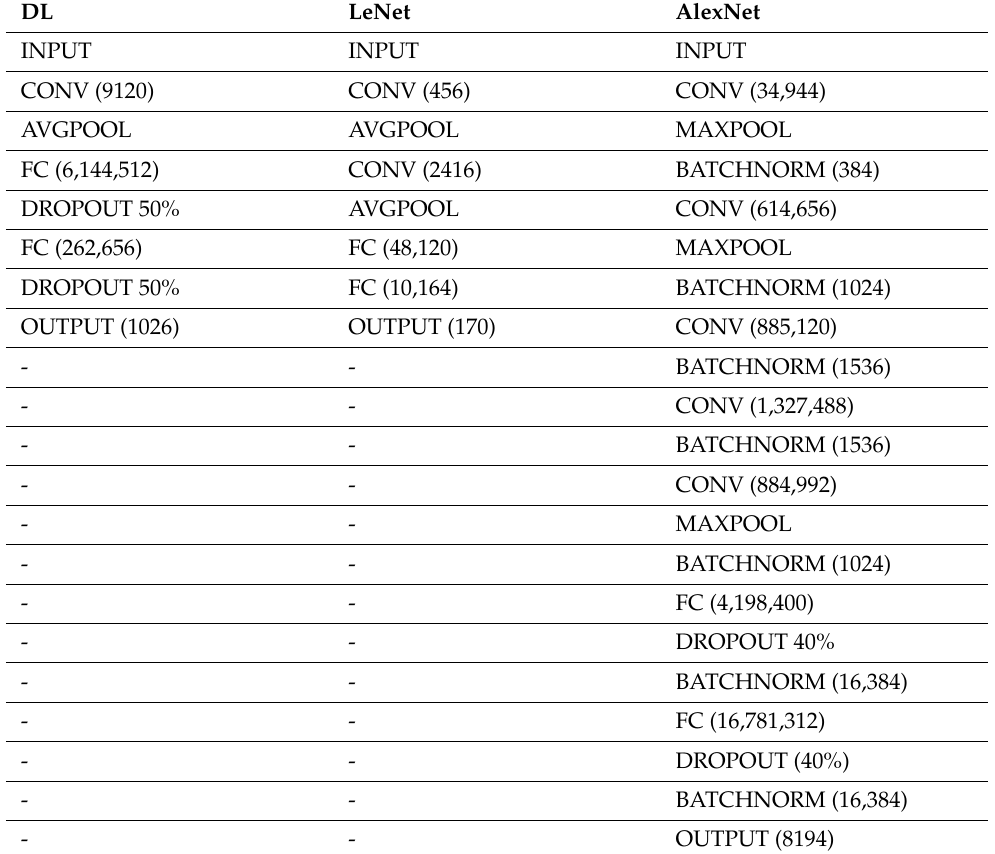
Table 3. Detailed overview of Layer Type (and no. of parameters) for all models. DL is the proposed model. LeNet and AlexNet are the compared models. No. of parameters is omitted when no parameters were there. DL LeNet